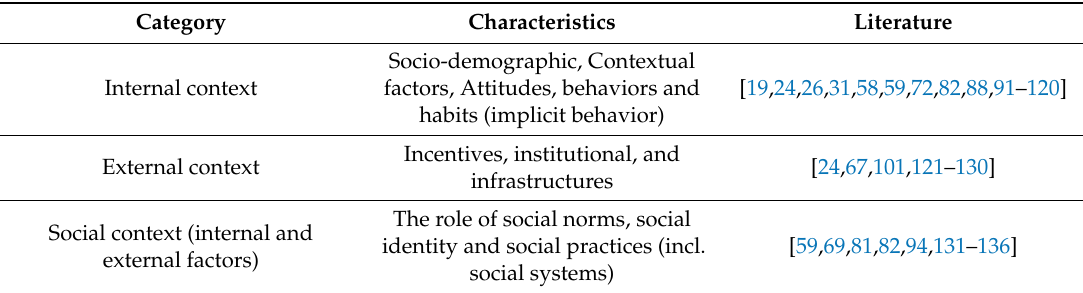
Table 3. Overview of the key literature that identify the factors a ff ecting households’ energy